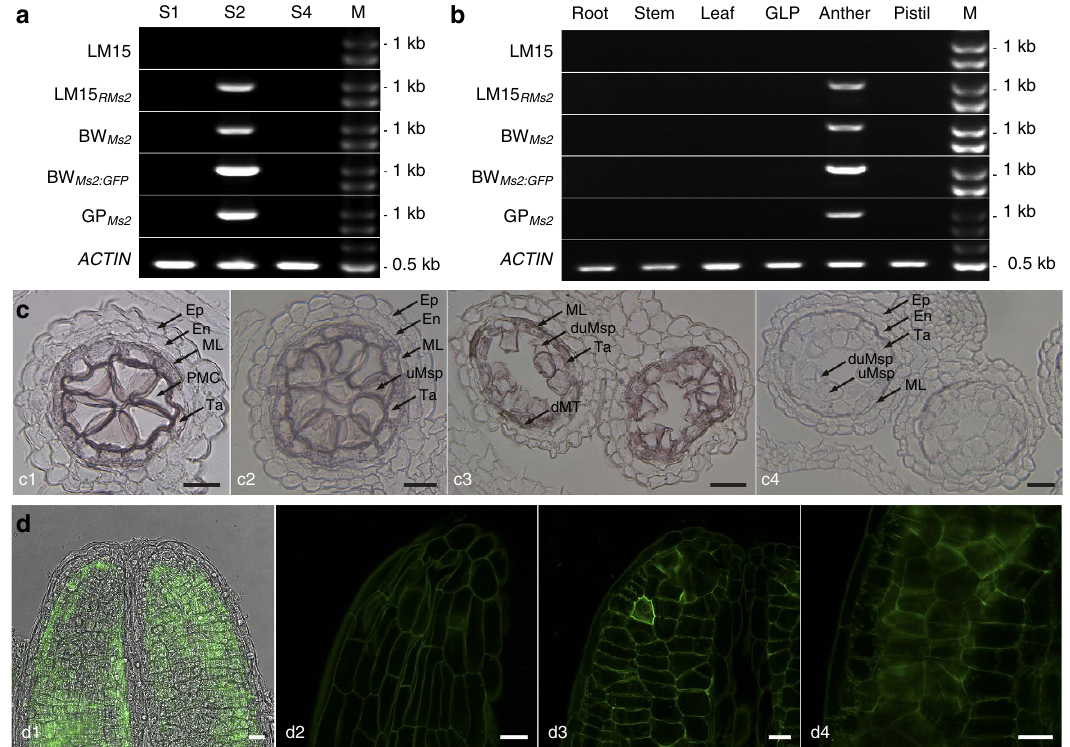
Figure 4 | Spatiotemporal expression of Ms2 . ( a , b ) Ms2 expression in anthers. BW Ms2 , BW Ms2:GFP , and GP Ms2 are male-sterile transgenic plants JZ7-2_2, JZ19-6, and 22-1A, respectively. GLP was pooled from glumes, lemma and palea. ( c ) In situ hybridization of Ms2 mRNA in cross sections of LM15 RMs2 stamens. Hybridization with antisense probes was detected in pollen mother cells (PMC, c1), early uninucleate microspores (c2), and late uninucleate microspores (c3); hybridization with sense probes was negative in uninucleate microspores (c4). ( d ) Ms2:GFP in optical sections of an undissected male-sterile anther (from JZ19-6) at the PMC stage. (d1) A superimposed laser scanning confocal and light micrograph showing GFP across the end of an anther. GFP was detected in the middle layer (d2), tapetum (d3) and PMC (d4). The experiment was repeated three times. En, endothecium; Ep, epidermis; ML, middle layer; Ta, tapetum; uMsp, uninucleate microspore; dMT, degenerated middle layer and tapetum; duMsp, degenerated uninucleate microspore; M, the 250bp DNA Ladder (GENEray, Shanghai, China). Scale bars, 25 m m ( c ) and 20 m m ( d